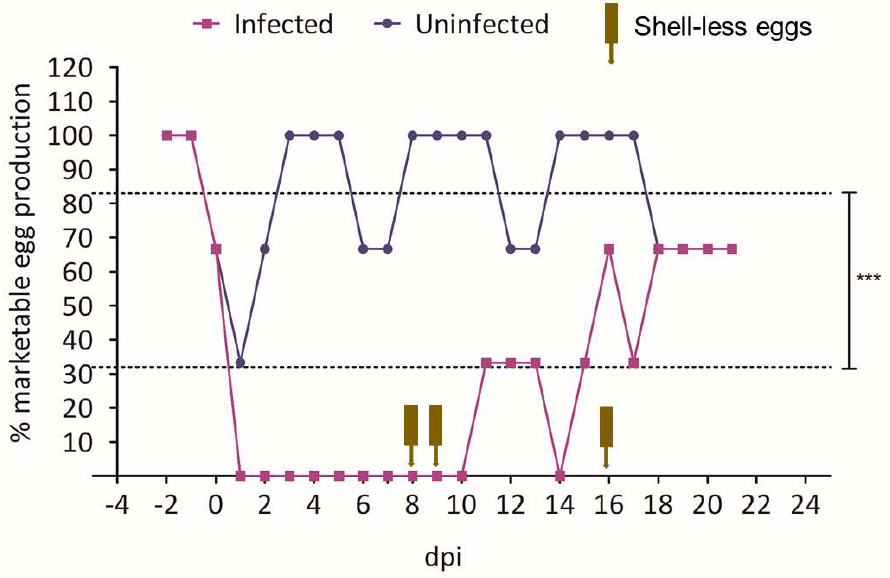
Figure 4. Egg production following infection with Mass type Western Canadian IBV isolate, 15AB-01. The percent daily egg production by the two groups of birds (only regular eggs are included in the percentage) is shown. Arrows indicate production of shell-less eggs. Dotted lines indicate the mean egg production values for the two groups; *** = p < 0.001—indicates a significant difference in total marketable egg production between infected and control groups during the observation period as analyzed by Chi-Square test. The difference in marketable egg production each day is binary (marketable eggs or not), as such, we used the Fisher’s exact test to see the difference in egg production each day.